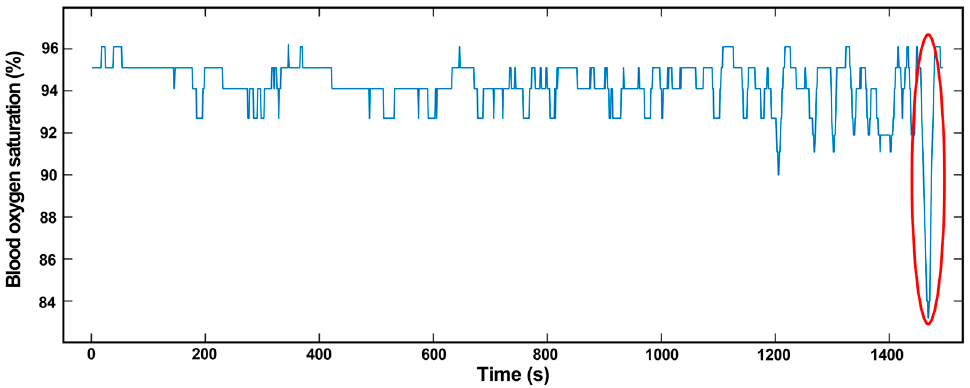
Figure 7. SpO 2 level variation with time for a wearer is measured by our smart ring. The significantly low SpO 2 level at the time of 1480 s indicates the sleeping apnea of the wearer.